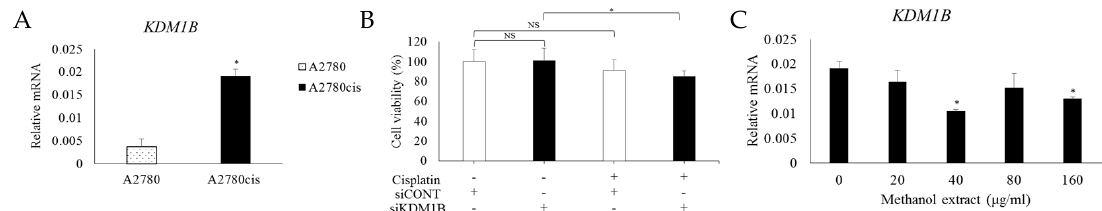
Figure 3. Cisplatin sensitivity increases in CRC after KDM1B downregulation. ( A ) KDM1B mRNA expression quantified in A2780 and A2780cis cells. ( B ) Transfection of siCONT and siKDM1B in A2780cis cells, followed by treatment with cisplatin for 48 h. Cell viability was measured with MTT assays. Following treatment with MOD (0 and 160 µ g / mL) for 48 h, ( C ) KDM1B mRNA expression as the mean ± STDEV. Student’s t-test was used to assess di ff erences between non-treated and treated group and between A2780 and A2780cis cells. * p < 0.05 was used to define statistical significance. NS: not significant.